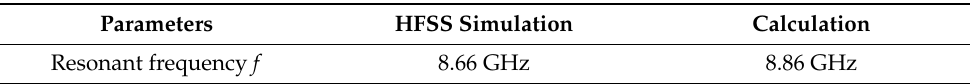
Table 4. Comparison between the resonant frequency of the Mode 2 antenna obtained by HFSS simulation and the calculation results of the coupling model.